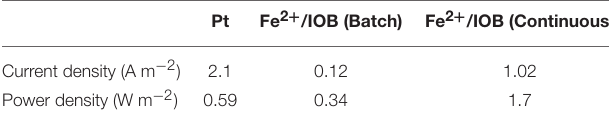
TABLE 2 | Summary of the performance achieved by the MFCs equipped with different